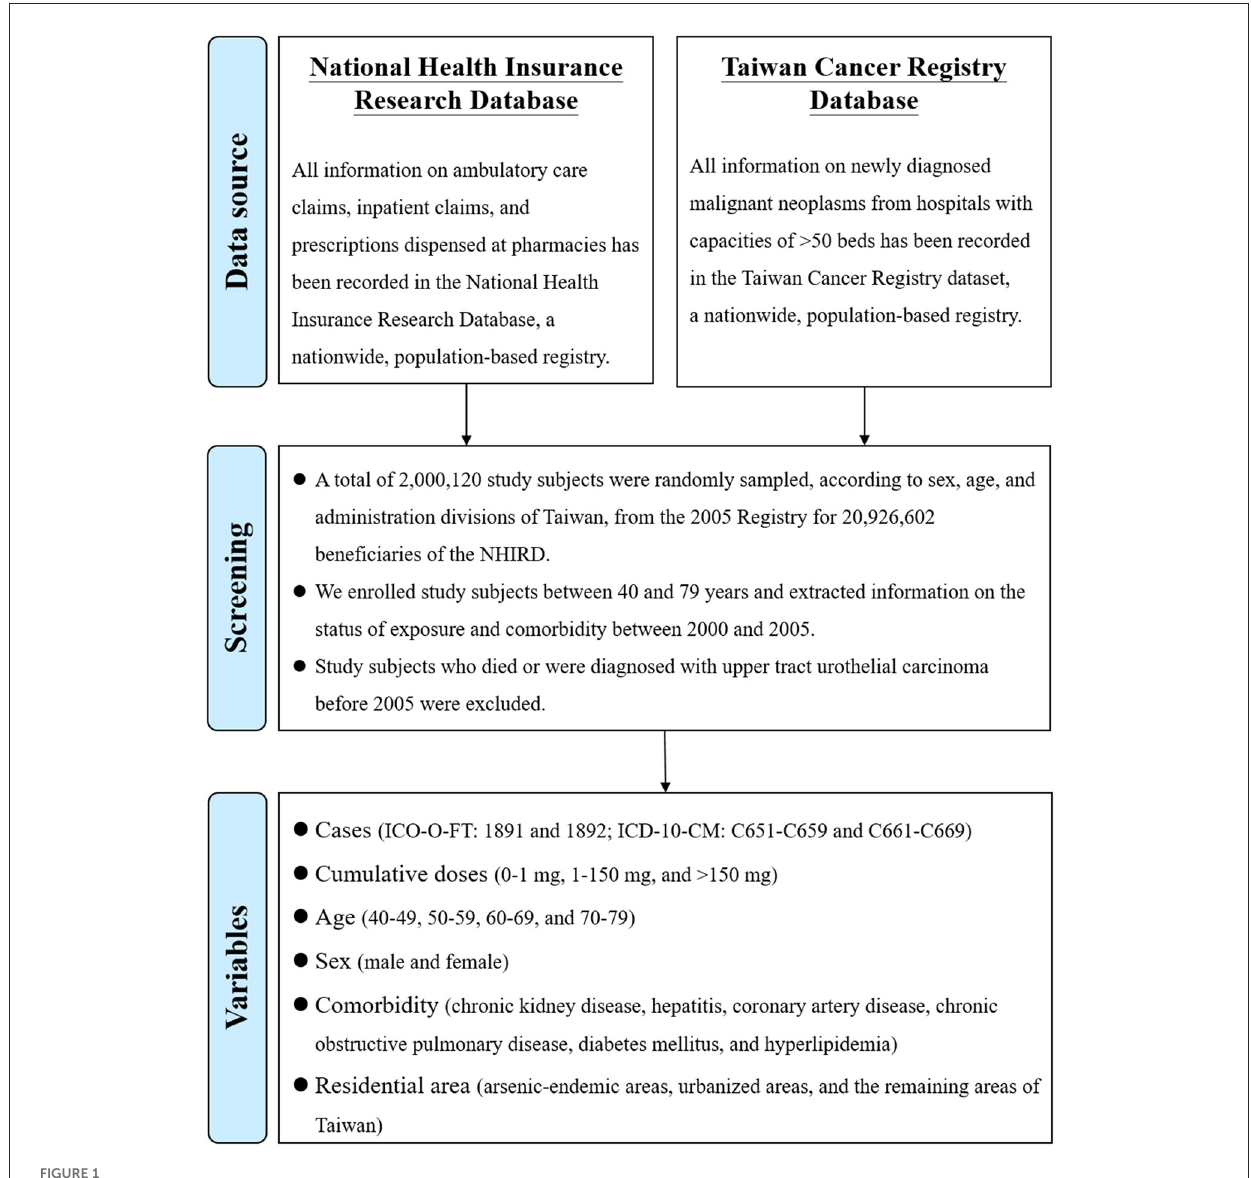
FIGURE1 Flowchart for recruitment of study